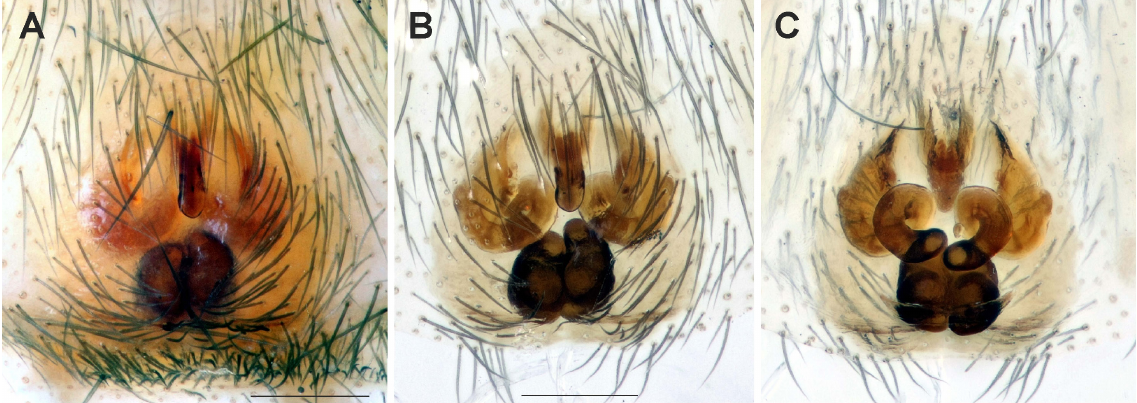
Fig. 26. Zagrotes apophysalis sp. nov., paratype, ♀ from type locality (MHNG), epigyne. A . Intact, ventral view. B–C . Macerated, ventral and dorsal views. Scale bars: 0.2